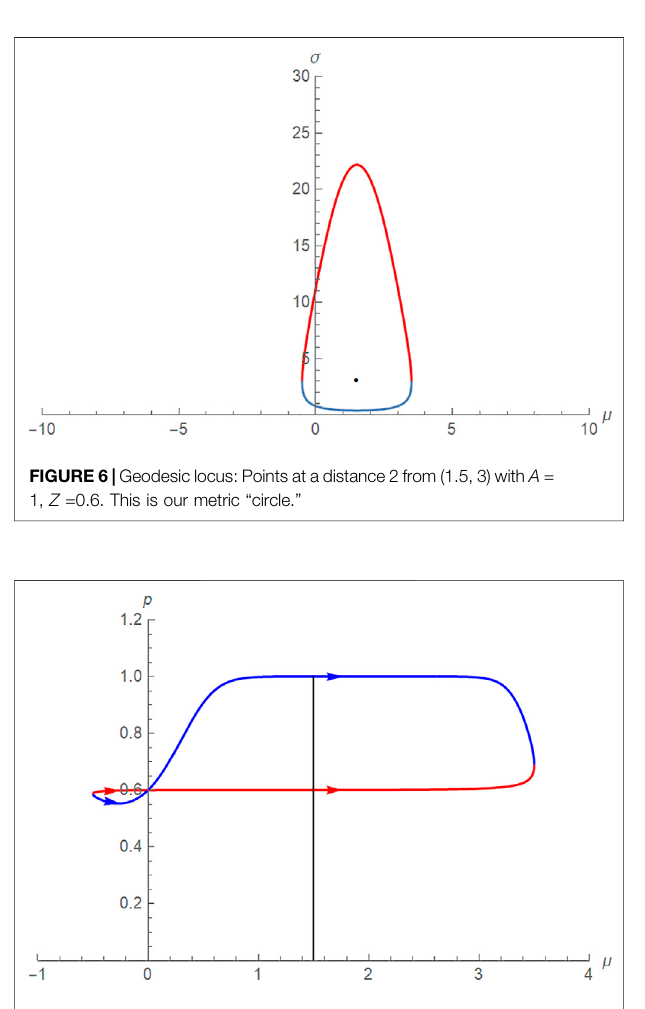
FIGURE 7 | P .6 ( z (cid:2) 1 ) of point distance 2 from ( μ , σ ) = (1.5, 3) as μ increases (indicated by arrow direction) from − 0.5 to 3.5. We see that for negative drift, the probabilities have an inverse behavior.